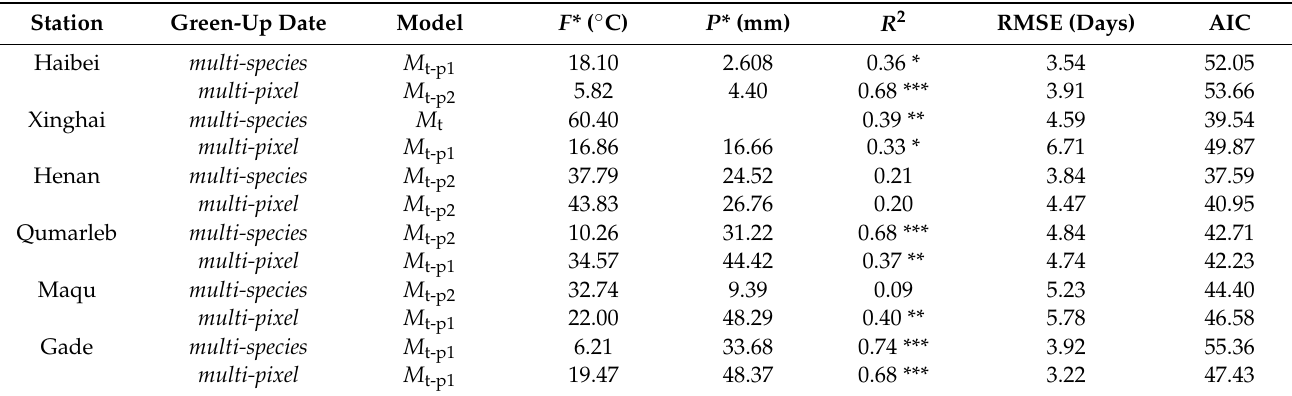
Table 2. Parameters of the optimum process-based models for ground observations and LSGO detections, respectively. Goodness of fit ( R 2 ), RMSE and AIC represent the quality of the optimum models at each